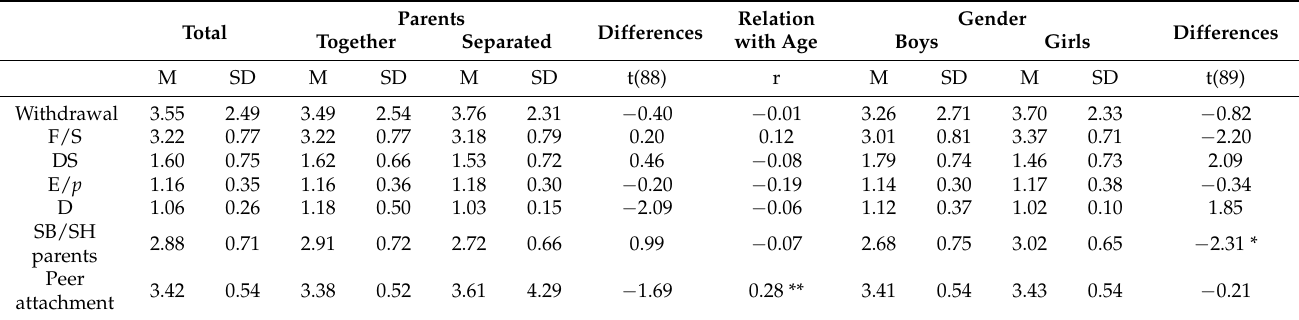
Table 1. Family structure, age, and gender differences on withdrawal a and attachment patterns b toward parents and peers in Italian